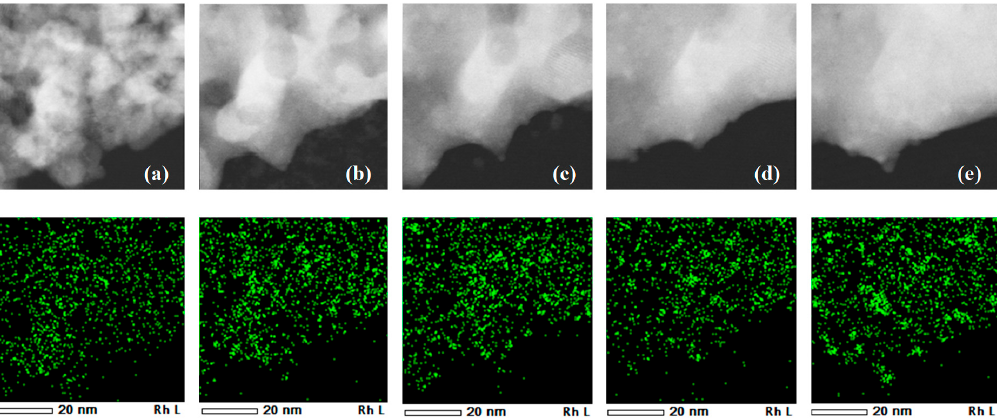
Figure 3. TEM images and EDS mapping of Rh in Rh/Y-ZrO 2 under vacuum conditions at ( a ) 300 °C, ( b ) 900 °C, ( c ) 950 °C, ( d ) 1000 °C, and ( e ) 1050 °C.